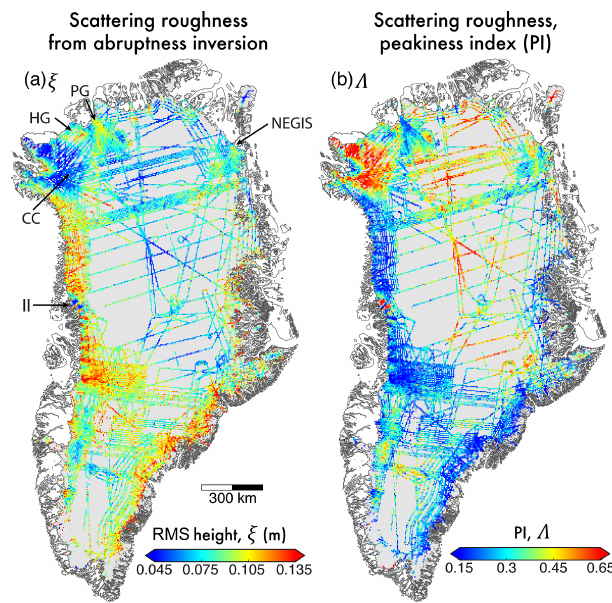
Figure 6. Scattering-derived roughness ( ξ ) across the GrIS. (a) ξ . (b) Non-dimensional (cid:51) (peakiness index) determined from the bed- echo waveform. Locations for Ìngia Isbræ (II), NEGIS, Petermann Glacier (PG), Humboldt Glacier (HG), and Camp Century (CC) drilling site, as referred to in the text, are